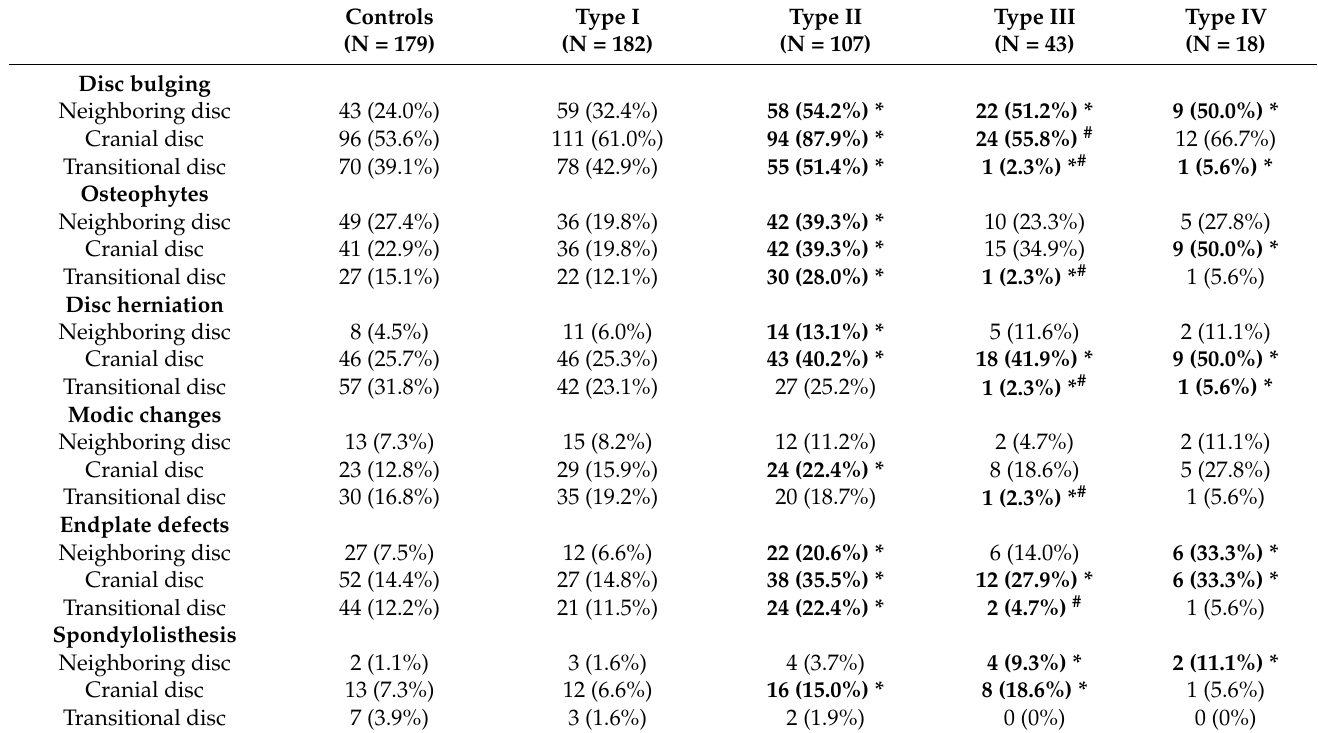
Table 1. Degenerative findings on lumbar MRIs for patients with LSTV and controls.